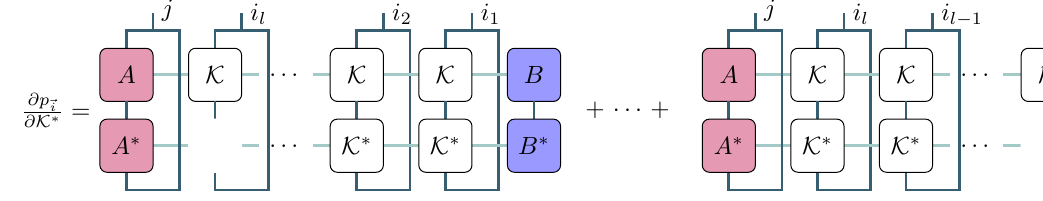
FIG. 8. Tensor network representation of first